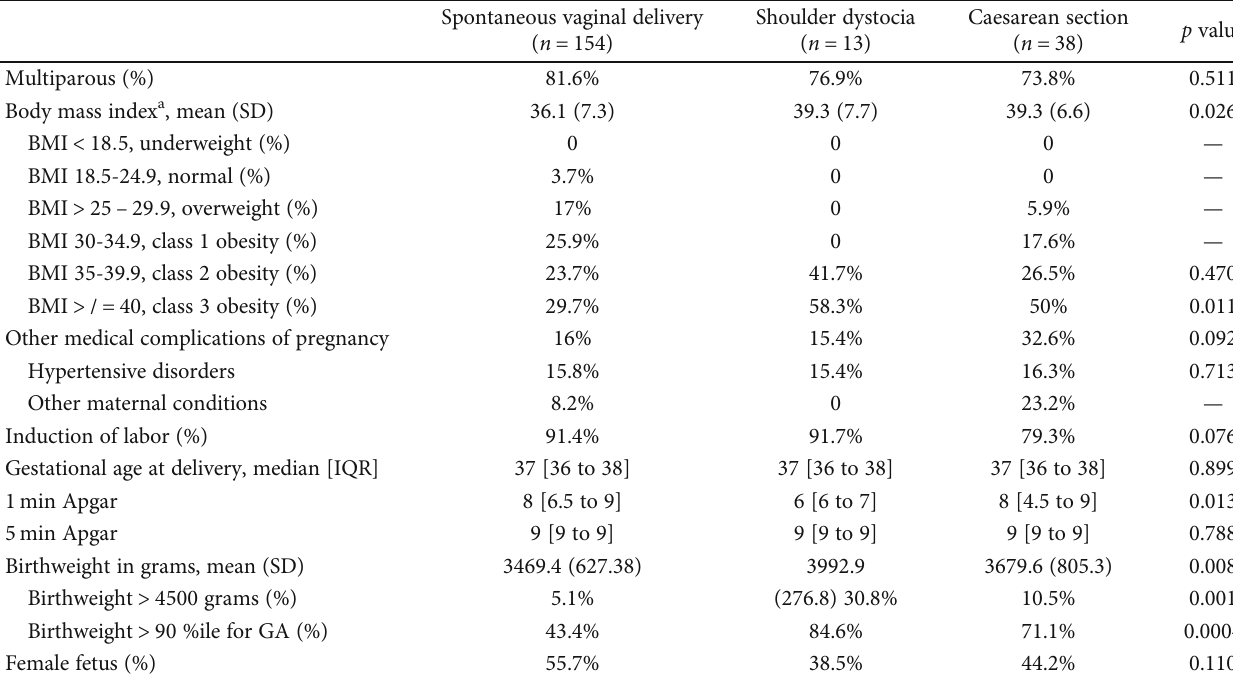
Figure 2: Proportion of deliveries complicated by shoulder dystocia and intrapartum Caesarean section (CS), compared to the baseline CS risk in the population (25.4%) [20]. Table 2: Perinatal characteristics and birth outcomes associated with intrapartum